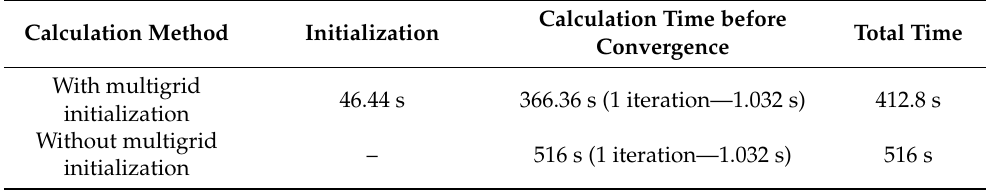
Figure 23. Drag convergence (LM1021).